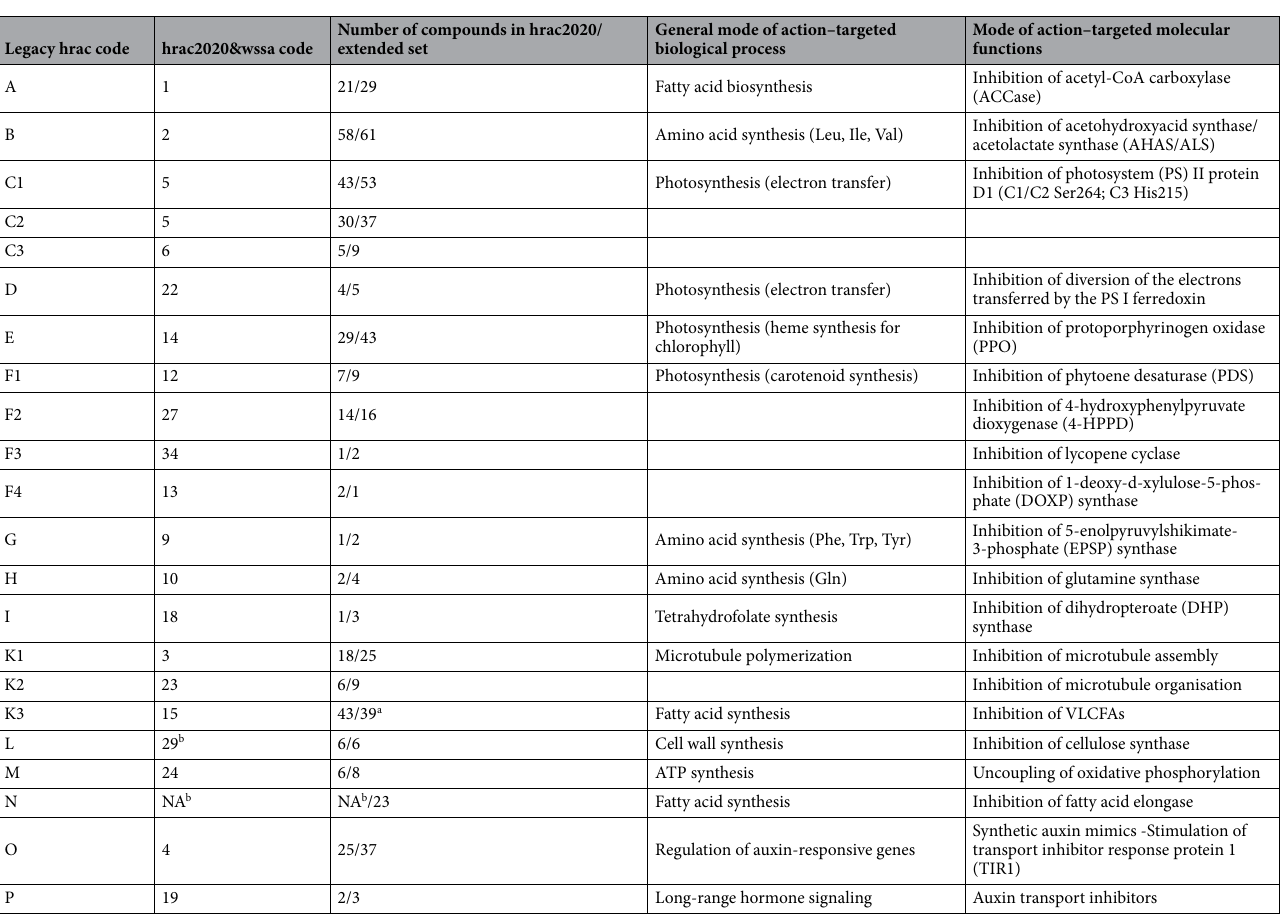
Table 1. HRAC classification and division of herbicides from the HRAC2020 and extended data sets across the MoA classes a . a In the HRAC2020 classification there are additional classes Q (3), R (31), S (32) and T (33), all with up to 2 members 5 . b Majority of herbicides from the class N are fused in the K3 (15) class. The